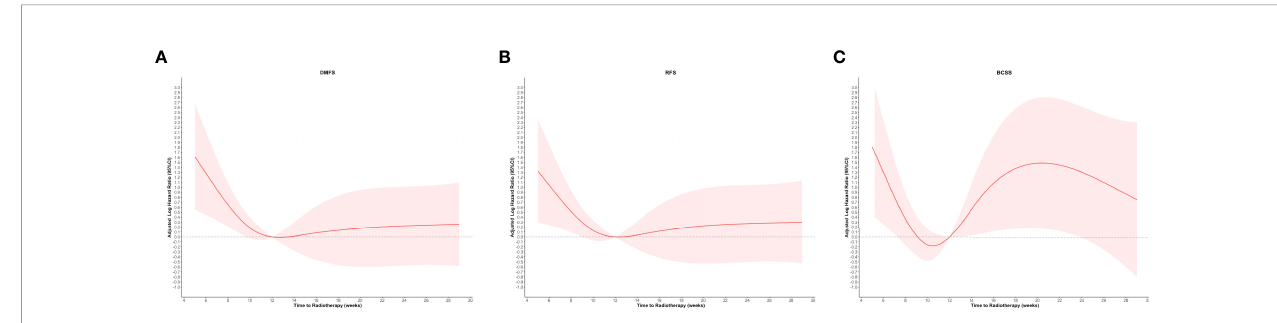
FIGURE 2 | Restricted cubic spline modeling of the relationship between the time to initiation of adjuvant radiotherapy and survival outcomes of distant metastasis- free survival (DMFS), recurrence-free survival (RFS), and breast cancer – speci fi c survival (BCSS). The log of the hazard ratios (HRs) derived from a multivariate Cox regression model is shown on the y-axis. The 95% Cis of the adjusted HRs are represented by the shaded area. (A) DMFS; (B) RFS; and (C)